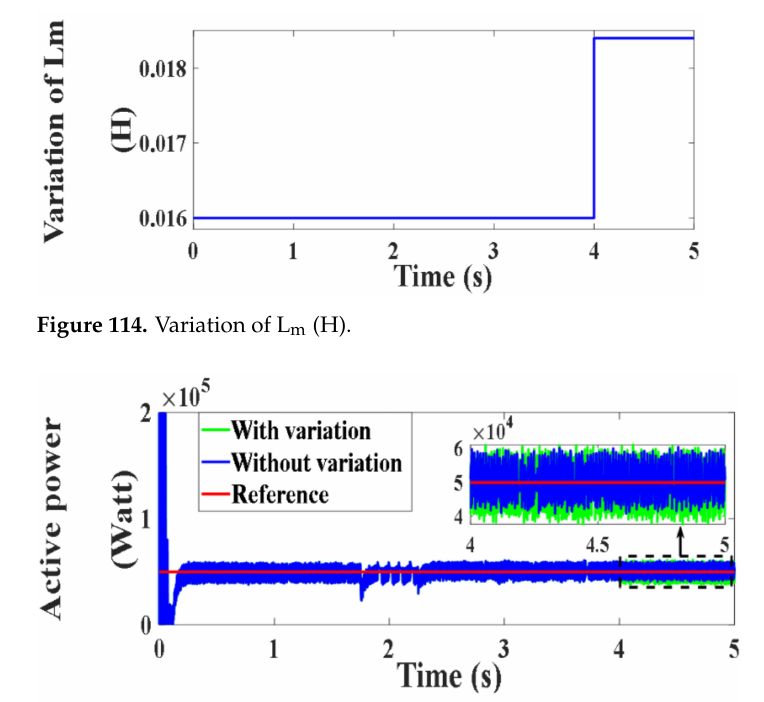
Figure 115. Active power under PVC (Watt).